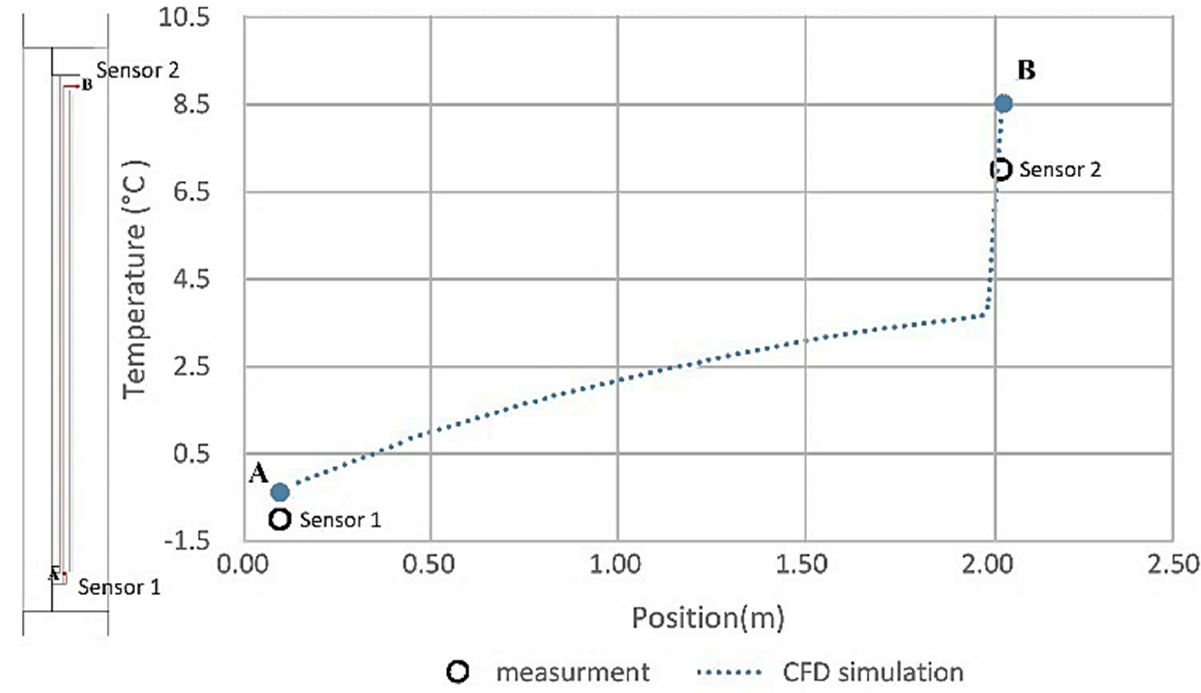
Figure 6. Left: Schematic section through the examined ventilated window with the position of the two temperature probes ( A to B ); right: Measured (sensors A and B ) and simulated temperature profile. The distance information ( x -axis) denotes the relative distance from the position of sensor A ).